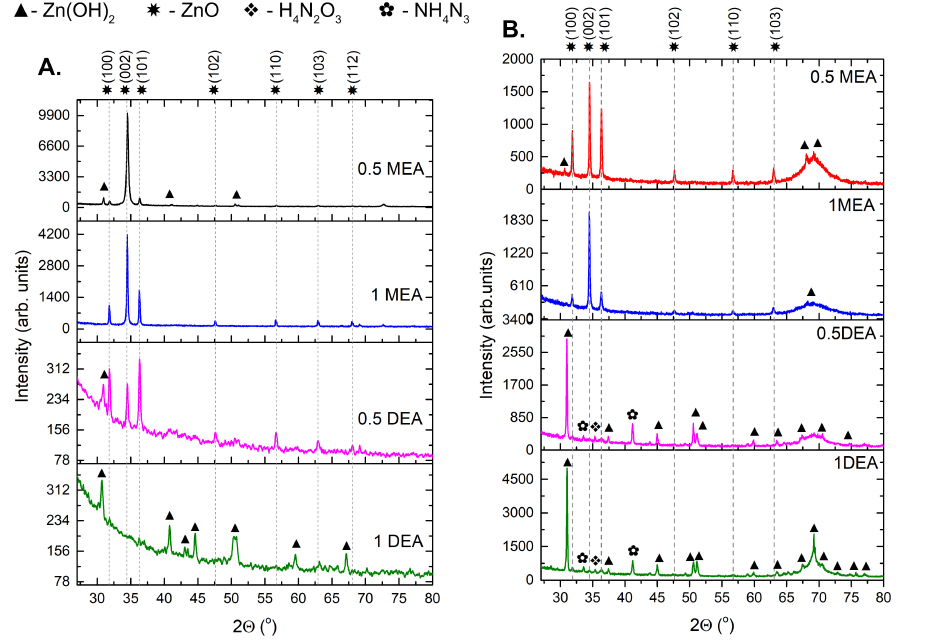
Figure 7. XRD pattern for samples grown on: ( A ) sapphire and ( B ) silicon. The gray lines relate to the position of the ZnO peaks; the rest of the phases are described with